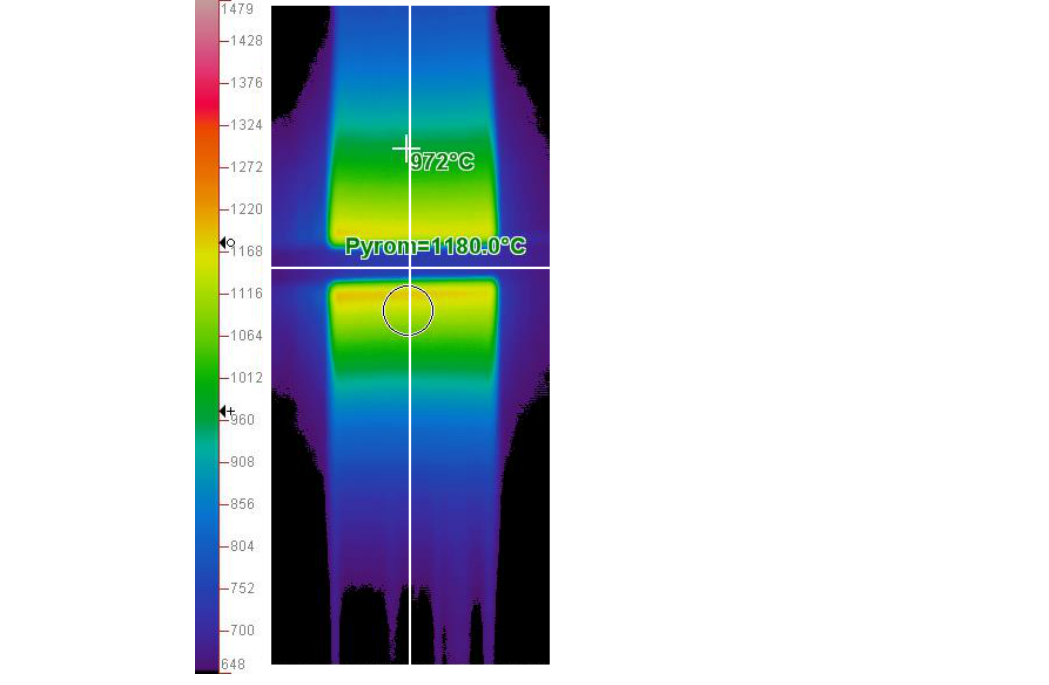
Figure 1. Infrared image 3 min before the end of heating. The superimposed horizontal white line shows the vertical position of the inductor mid-plane, while the vertical one denotes the location for the vertical temperature distribution T ( z ) . The main temperature reading of 1180.0°C is for a circular region (5.7mm in diameter) below the